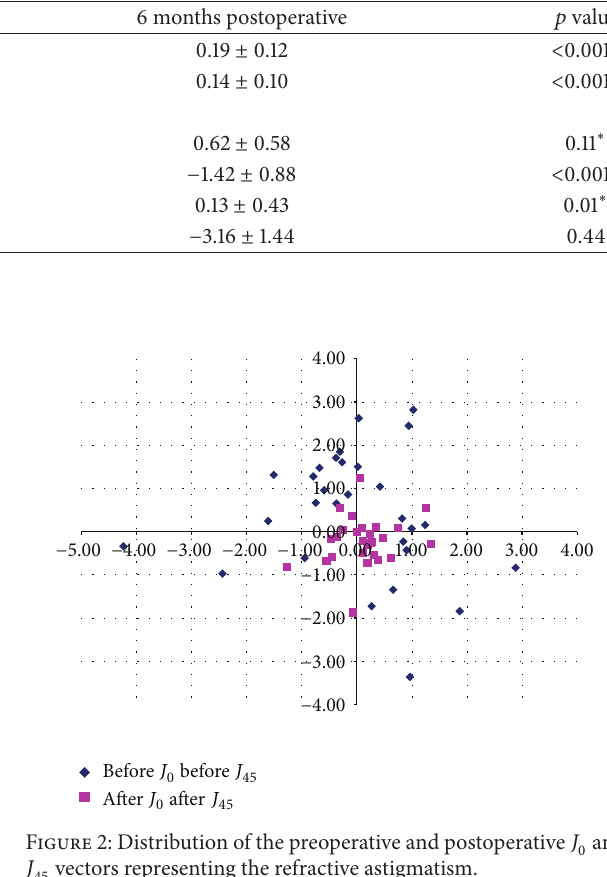
Table 2: Preoperative and 6-month postoperative visual and refractive outcomes.